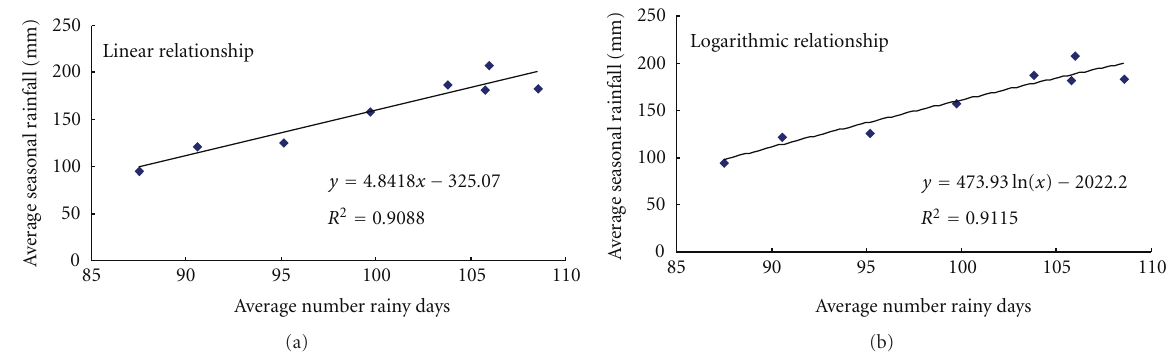
Figure 10: Relationship between Average seasonal rainfall and number of rainy days (a) Linear relationship (b) Logarithmic relationship.